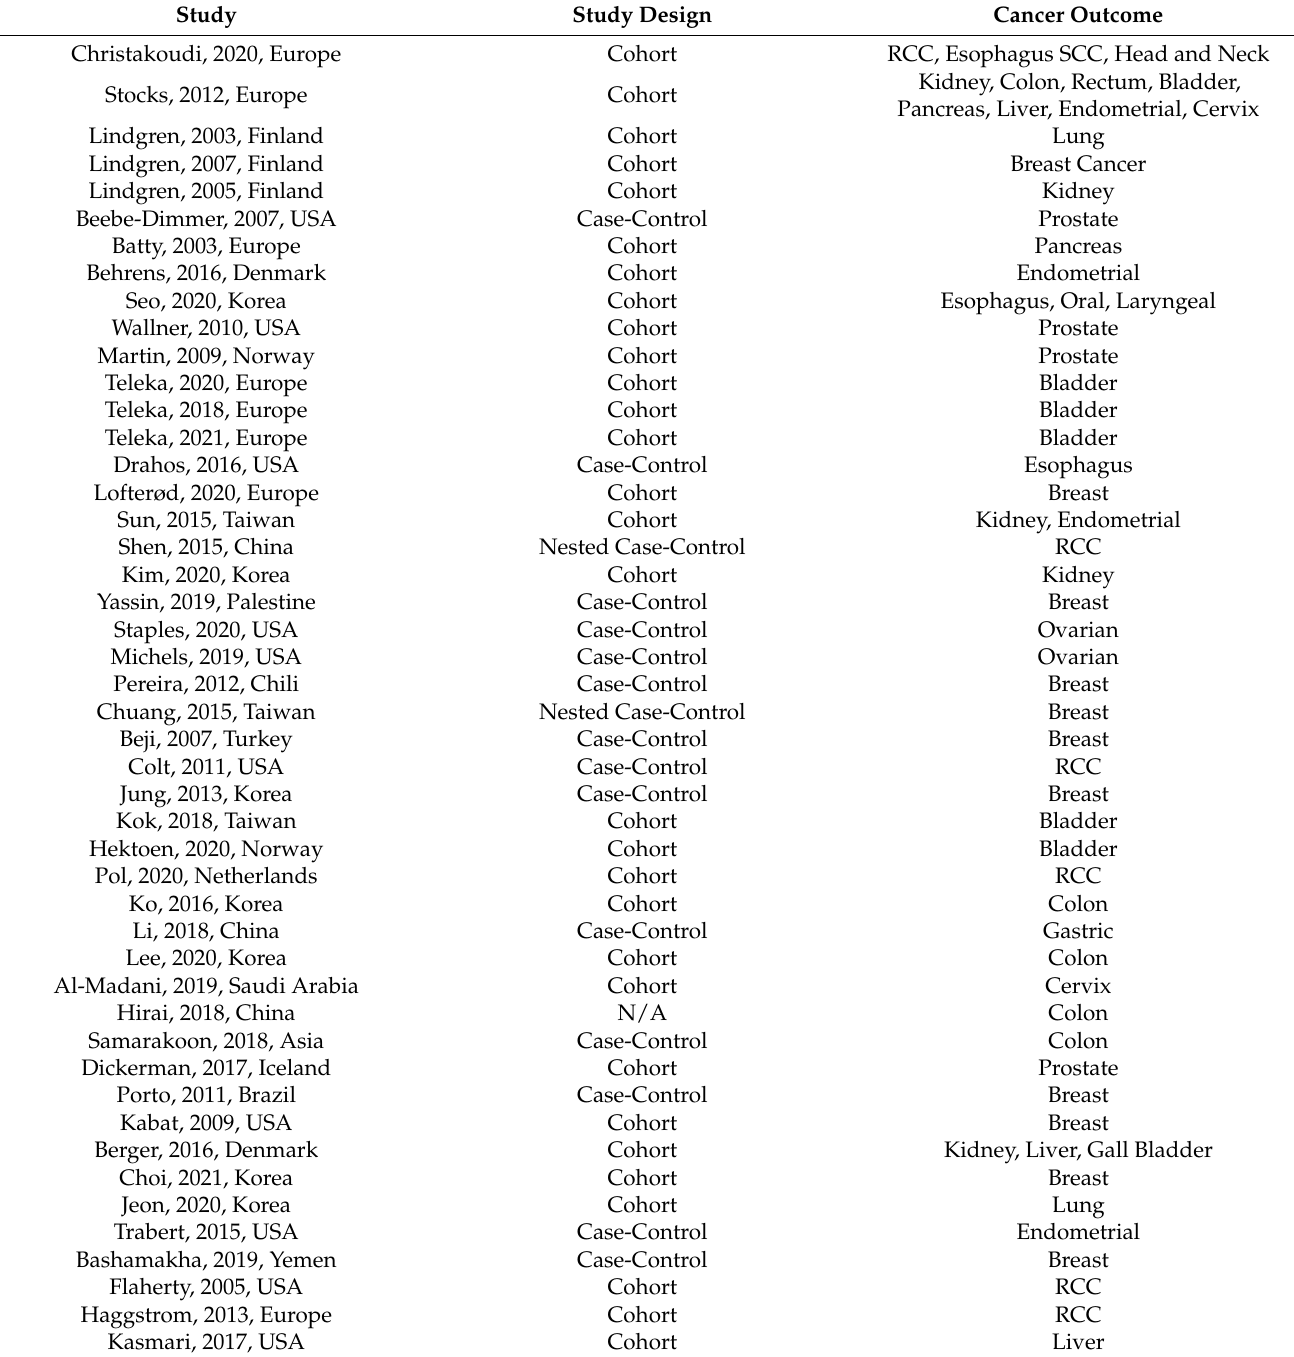
Table 1. Study characteristics. N/A, not